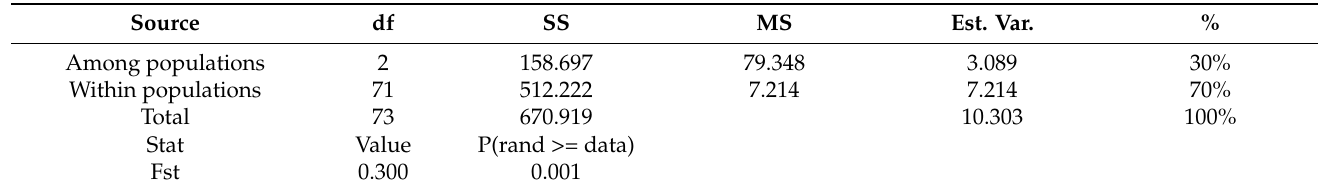
Table 11. Analysis of molecular variance (AMOVA) for different groups of M. officinalis How.